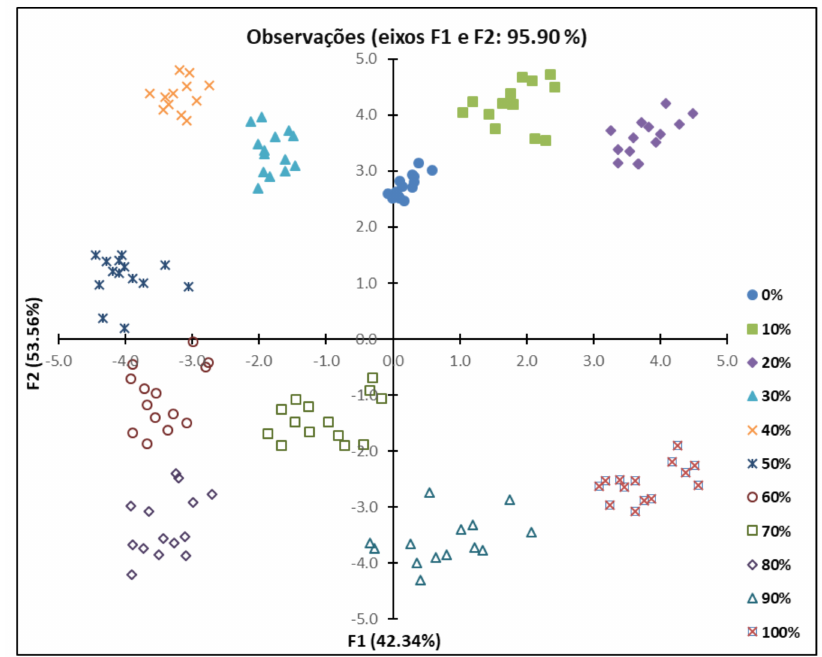
Figure 2. Observations diagram obtained by principal component analysis (PCA) using the Fourier transform infrared spectroscopy (FTIR) spectral data for the 11 formulations of Onconrhynchus mykiss (OM) and Salmo salar